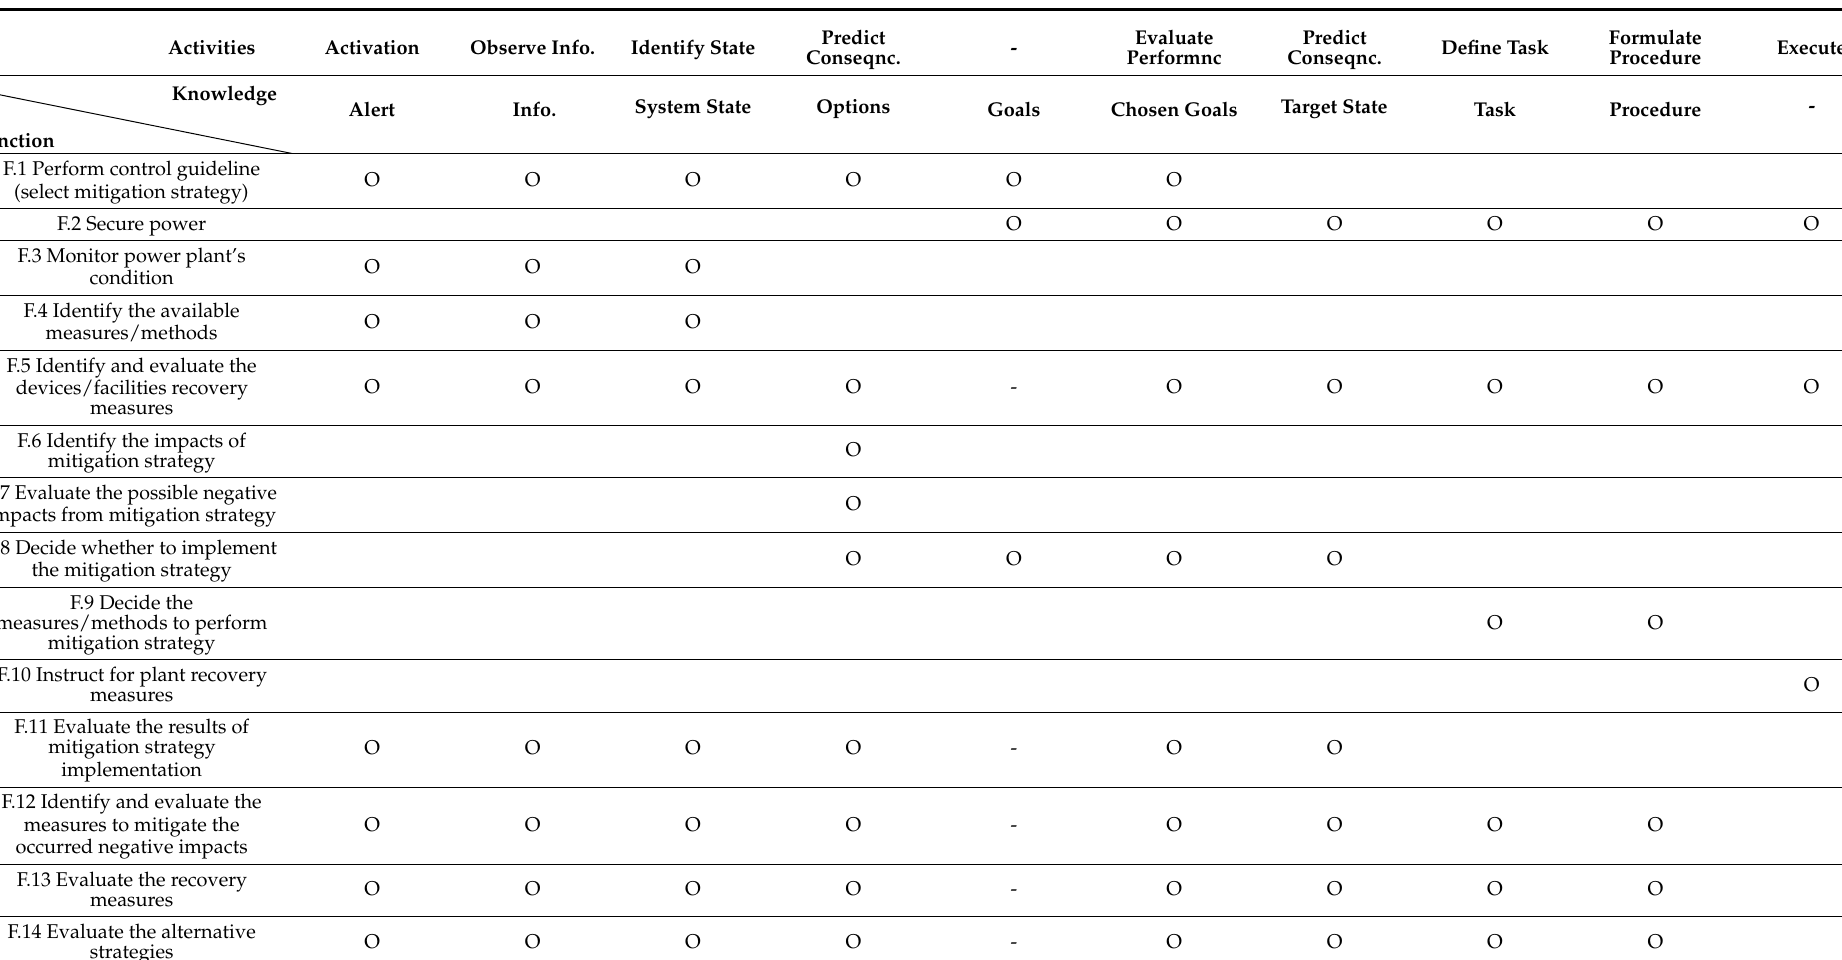
Table 2. FRAM-Decision Ladder